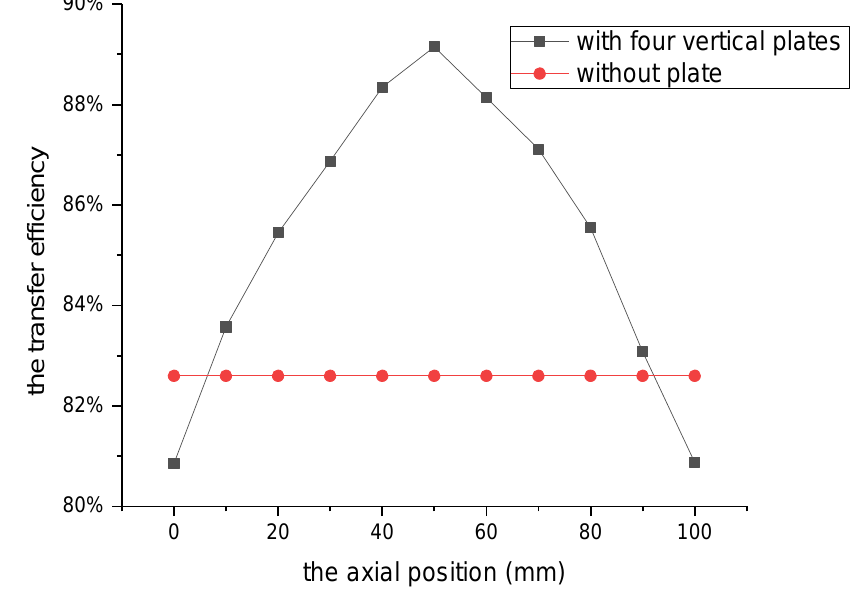
Figure 14. Experimental results of the variation of the efficiency with the axial position of the system with four vertical plates.